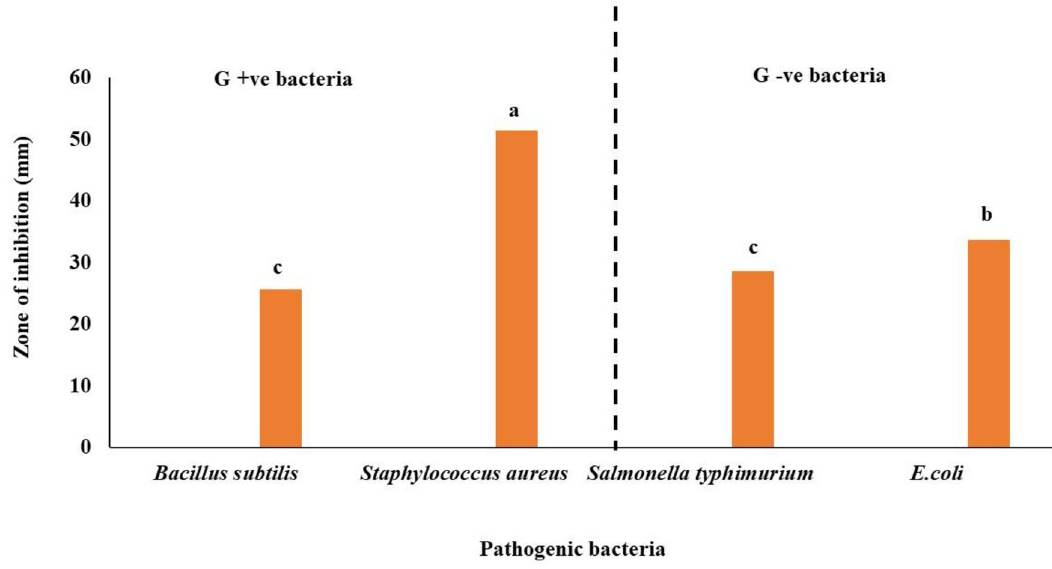
Fig 3. Antimicrobial activity of bioactive compounds of Streptomyces exfoliatus strain ‘MUJA10’ against Staphylococcus aureus , E . coli , Salmonella typhumurium and Bacillus subtilis